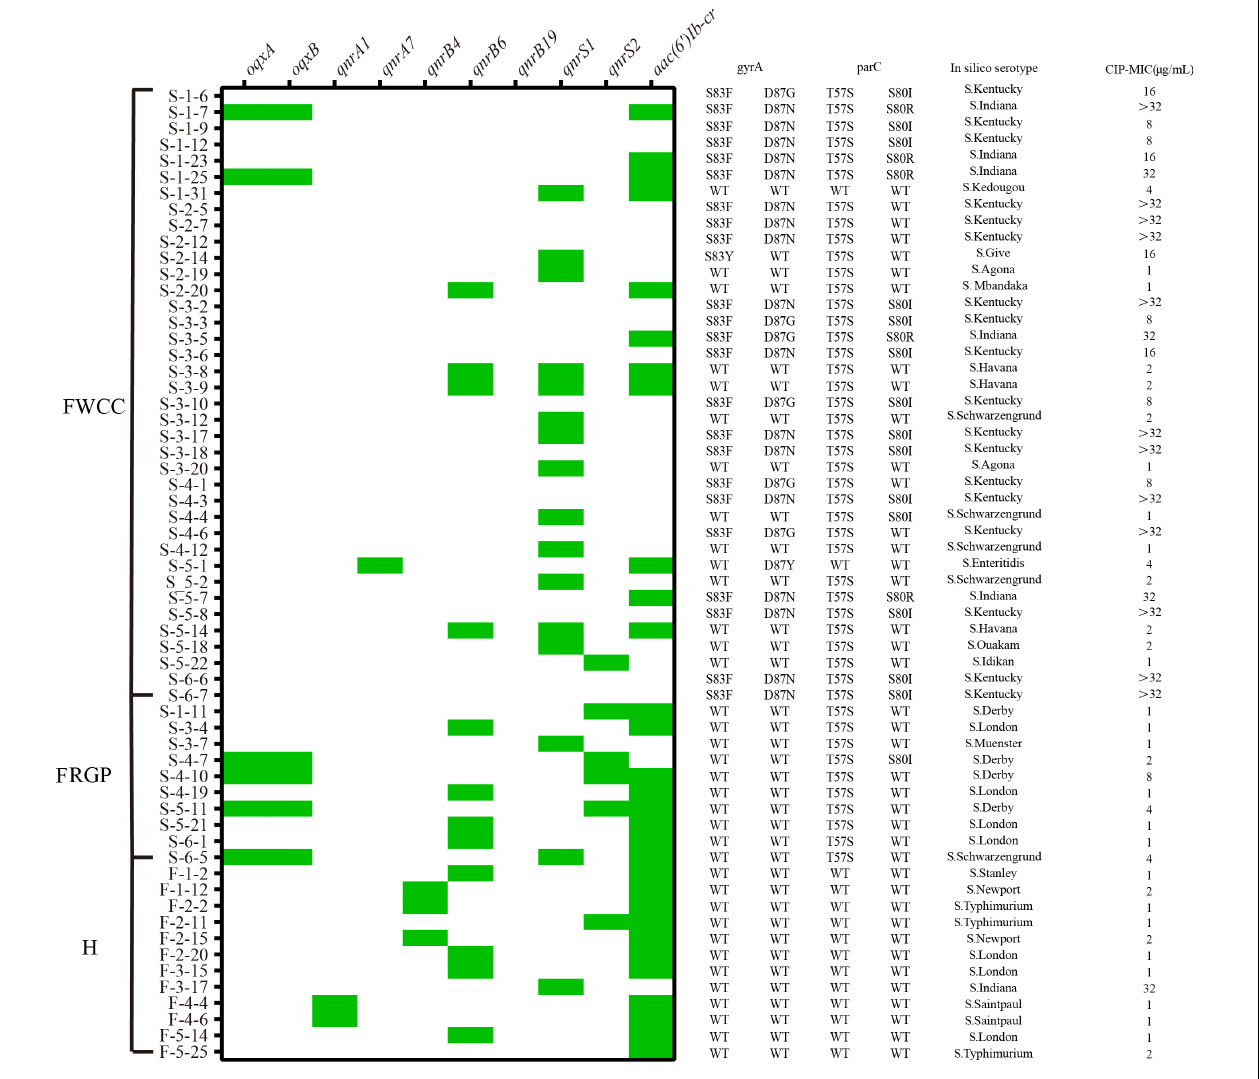
FIGURE 7 | Distribution of plasmid-mediated quinolone resistance (PMQR) genes, quinolone resistance-determining regions (QRDRs) mutations, serotypes, minimal inhibitory concentration (MIC) of ciprofloxacin (CIP) in the ciprofloxacin-resistant isolates from different sources ( n = 60). H, human; FWCC, frozen whole chicken carcasses; FGRP, frozen raw ground